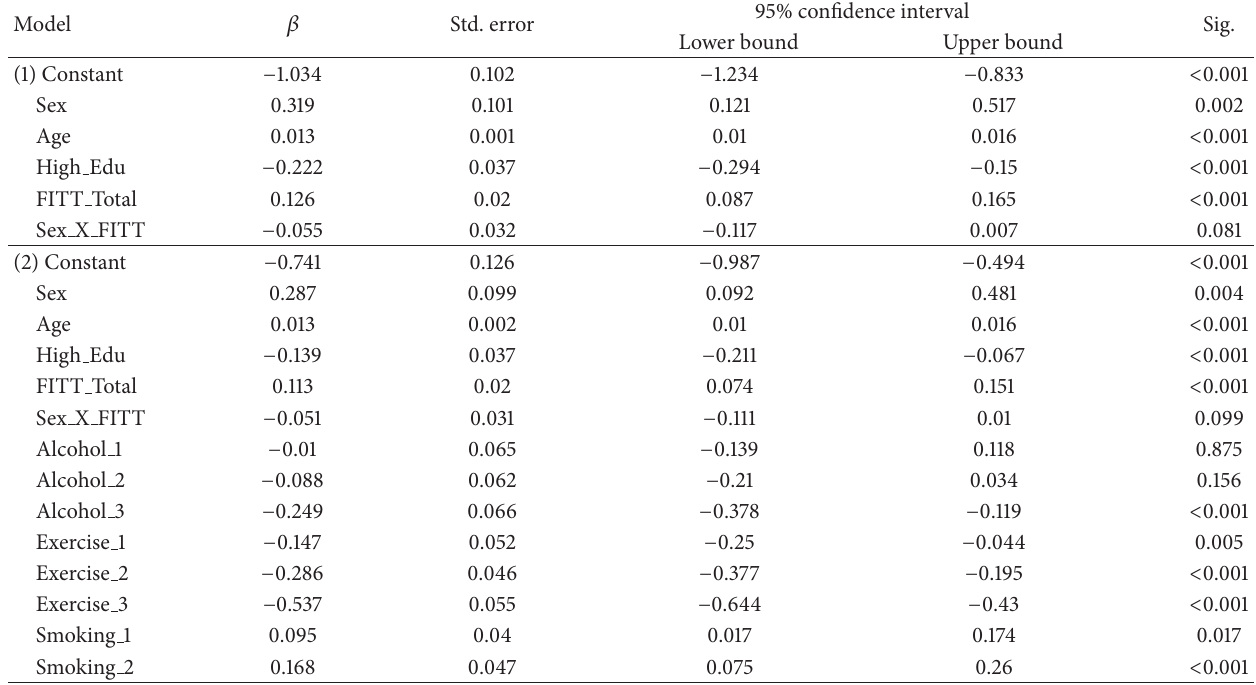
Table 5: Predictive model of chronic pain severity (FITT) and the risk factor composite. Model